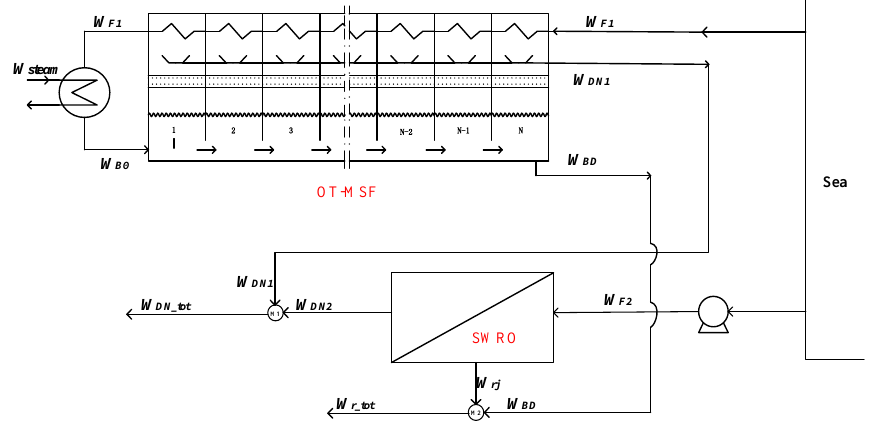
Figure 1. Option 1 — the OT-MSF system and SWRO system with independent feed water. Figure 1. Option 1—the OT-MSF system and SWRO system with independent feed